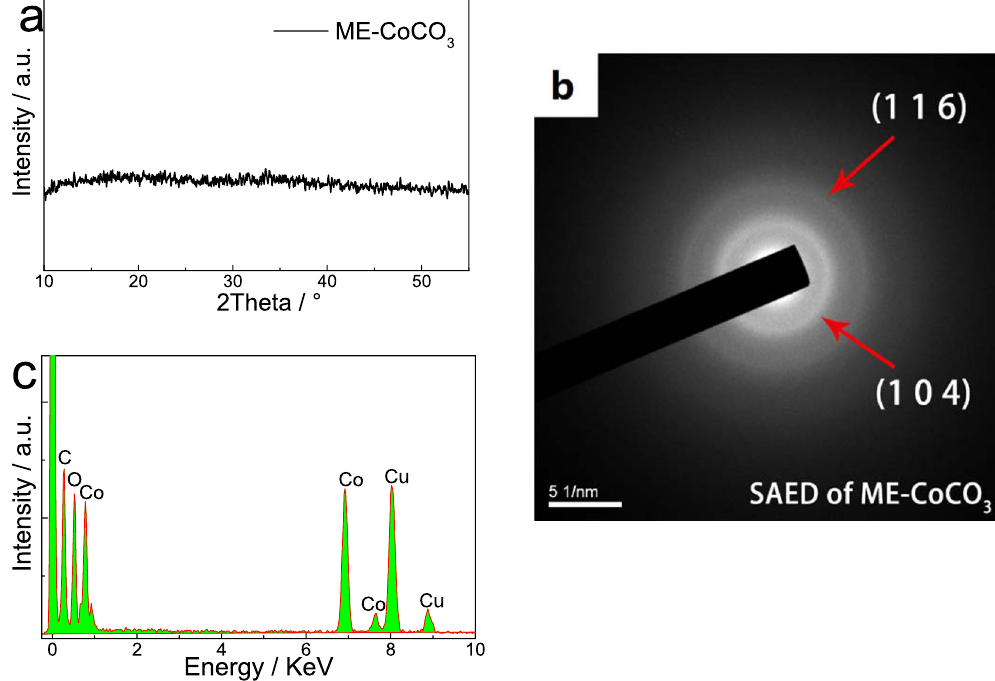
Figure 1. Some physical properties of the prepared ME-CoCO 3 : ( a ) XRD patterns ( b ) selected area electron diffraction (SAED) micrograph, and ( c ) energy dispersive X-ray spectroscopy (EDX)